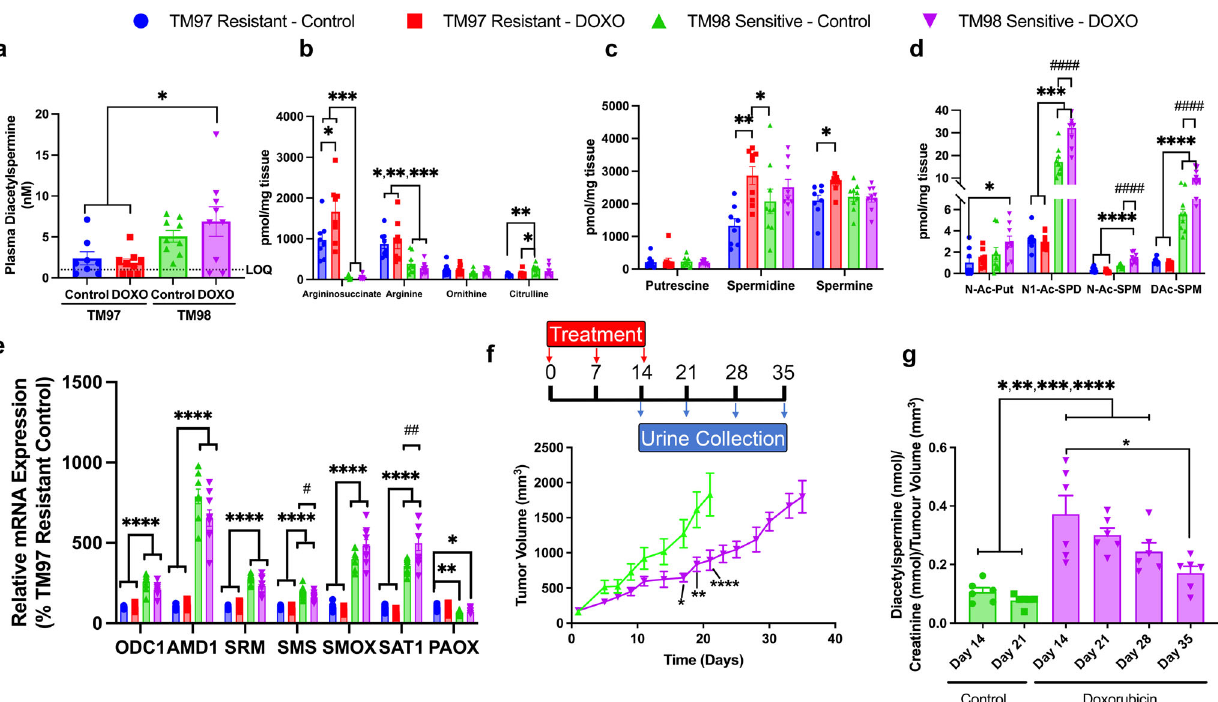
Fig. 2 Doxorubicin treatment increases SAT1 expression and tumor production of diacetylspermine, which is sustained following the fi nal dose. a Plasma diacetylspermine and tissue urea cycle ( b ), polyamine ( c ) and acetylated polyamine ( d ) metabolites from TM97 and TM98 TNBC-PDX mice treated with vehicle (5% dextrose, IV) or doxorubicin (DOXO, 2 mg/kg, IV). e mRNA expression of polyamine pathway enzymes in TM97 and TM98 TNBC-PDX mice treated with vehicle or doxorubicin. f TM98 mice treated with vehicle or doxorubicin and placed in metabolic cages for urine collection as indicated. g Urine diacetylspermine normalized to tumor volume. Data are presented as mean ± s.e.m. n = 8 – 9 ( a – e ), n = 6 ( f , g ). Signi fi cance was determined by one-way ANOVA with Tukey ’ s test or two-way repeated measures ANOVA with Sidak ’ s correction, * P < 0.05, ** P < 0.01, *** P < 0.01, **** P < 0.0001 vs TM97; # P < 0.05, ## P < 0.01, #### P < 0.0001 vs TM98 control. Plasma concentrations below the limit of quanti fi cation (LOQ) were calculated as